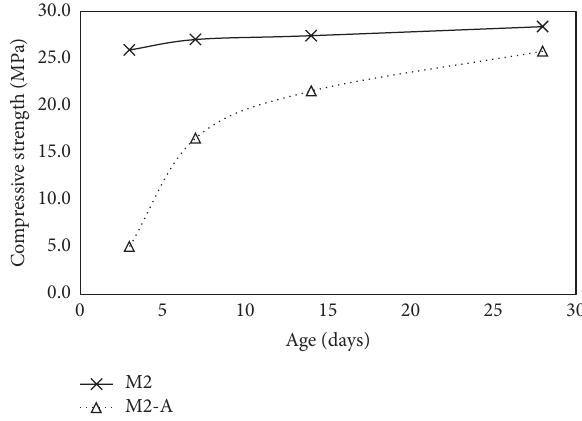
Figure 1: Effect of POFA on 28-day compressive strength. Figure 2: Effect of curing methods on the strength development.